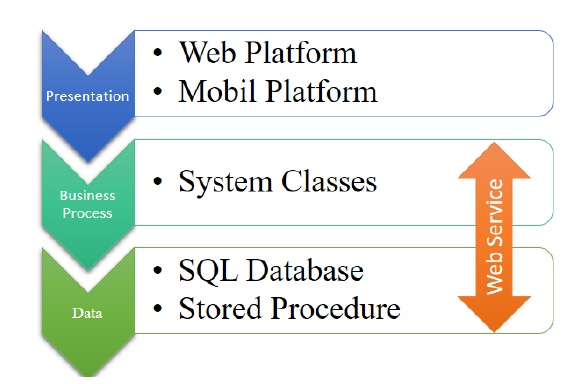
Figure 2. System background architecture